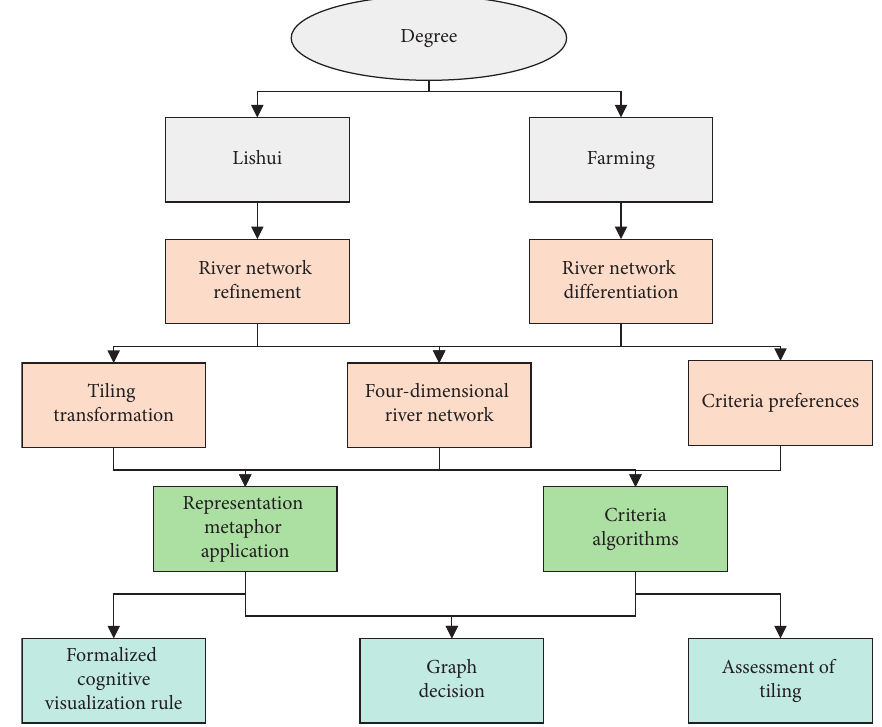
Figure 1: Geomorphic influence relationship